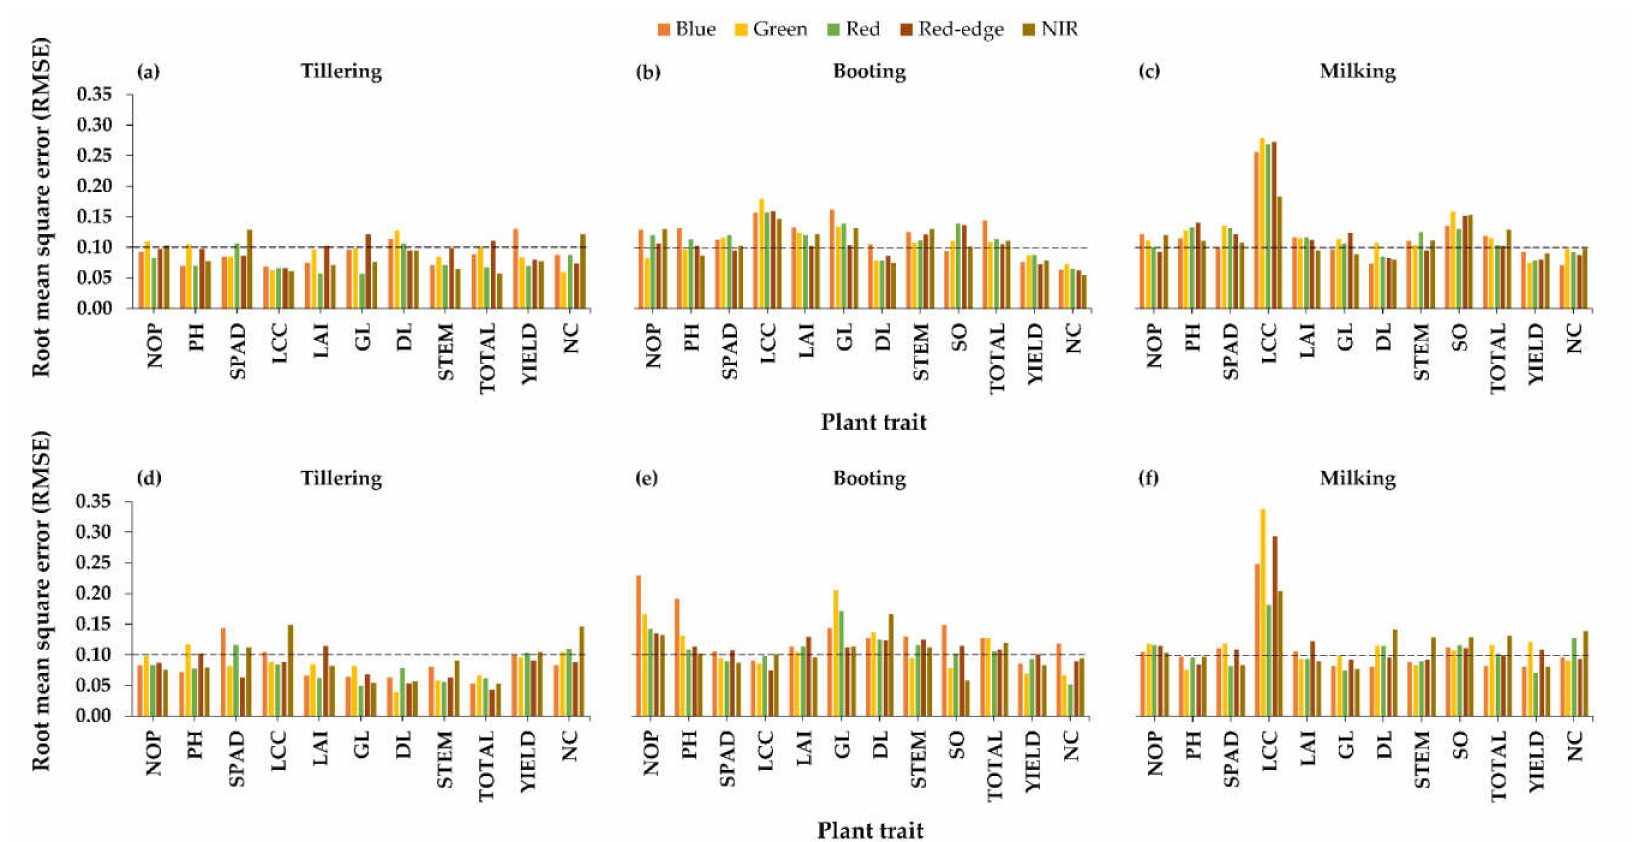
Figure 3. RMSE values for the raw band’s training ( a – c ) and testing ( d – f ) models for all plant traits at different rice growth